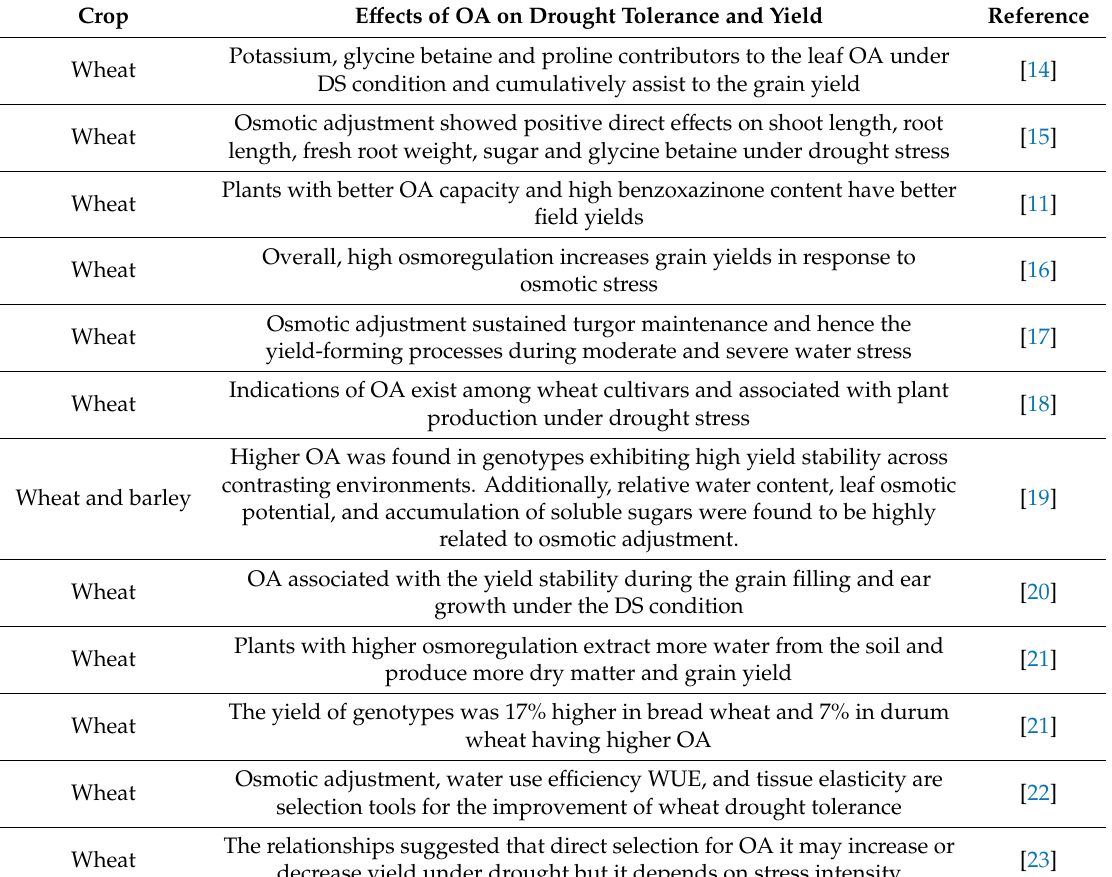
selection tools for the improvement of wheat drought tolerance The relationships suggested that direct selection for OA it may increase or decrease yield under drought but it depends on stress